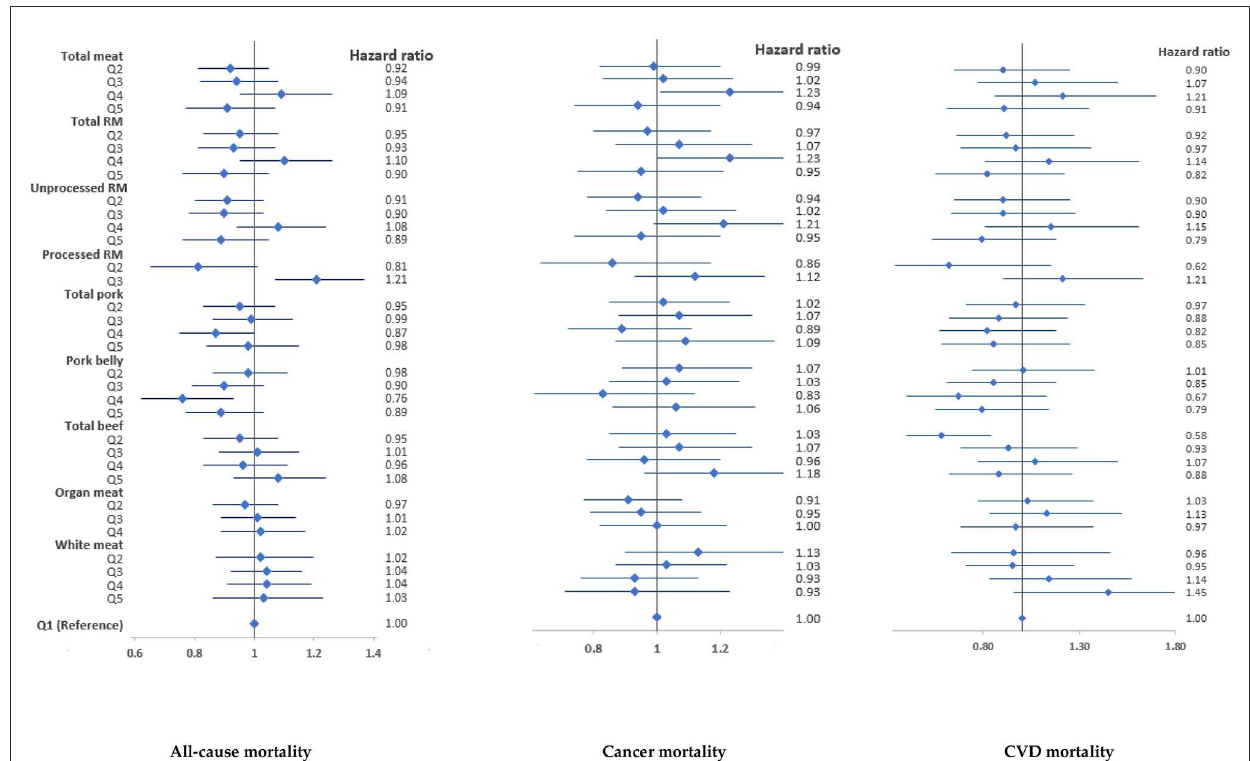
FIGURE2 Associations of meat intake with all-cause and cause-specific mortality in the HEXA-G study in men. Points are hazard ratios, and lines represent 95% confidence interval. Models were adjusted for baseline age, marital status, education, income, job, smoking, drinking, regular physical exercise, total energy intake, total meat intake (for specific meat types), history of chronic diseases, and body mass index. RM, Red meat. 95% confidence intervals, sample sizes and person years are shown in Supplementary Table